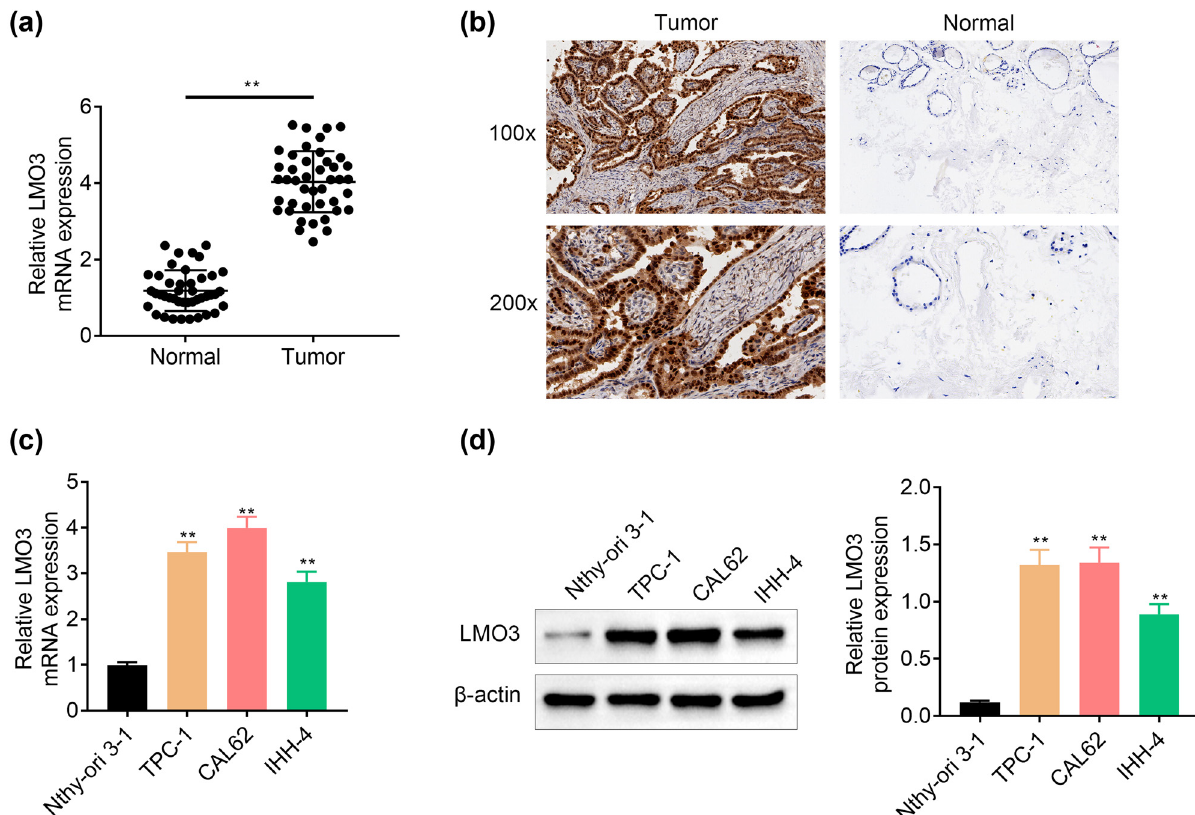
Figure 1: Upregulation of LMO3 in PTC. ( a ) LMO3 expression was elevated in the PTC tissues compared to that in the adjacent normal tissues via qRT - PCR analysis. ( b ) LMO3 expression was elevated in the PTC tissues compared to that in the adjacent normal tissues via immu - nohistochemical analysis. ( c ) LMO3 expression was elevated in the PTC cell lines ( TPC - 1, CAL62, IHH - 4 ) compared to that in the normal human thyroid cell line ( Nthy - ori3 - 1 ) via qRT - PCR analysis. ( d ) LMO3 expression was elevated in the PTC cell lines ( TPC - 1, CAL62, IHH - 4 ) compared to that in the normal human thyroid cell line ( Nthy - ori3 - 1 ) via western blot analysis. ** vs normal or Nthy - ori3 - 1, p <